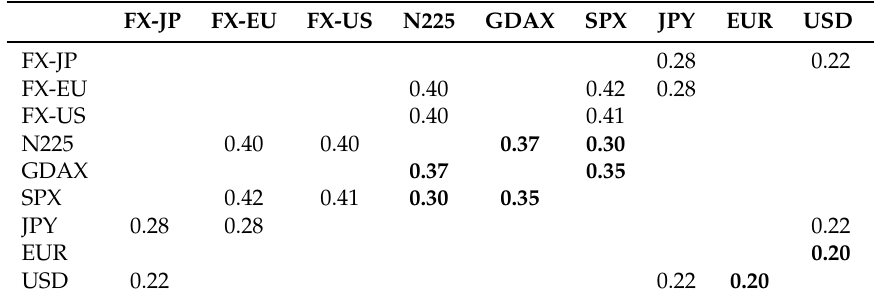
Table 8. Memory estimates on the